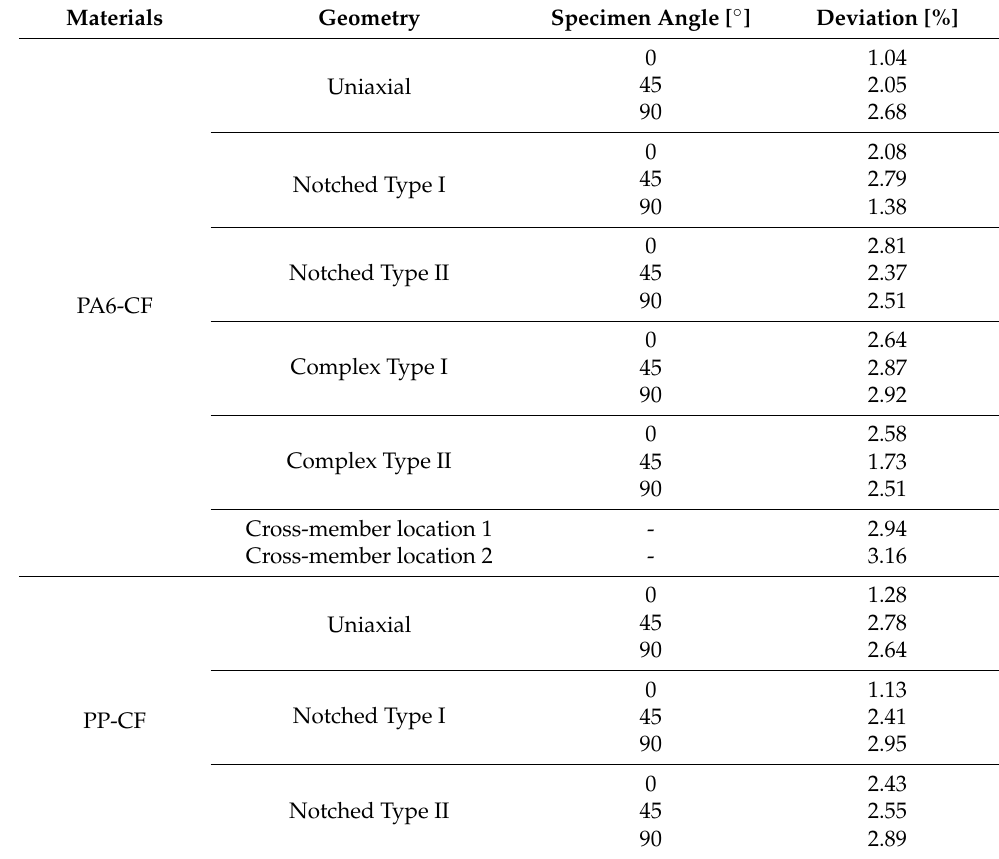
Table 6. The deviation between the experimental and simulation load-displacement